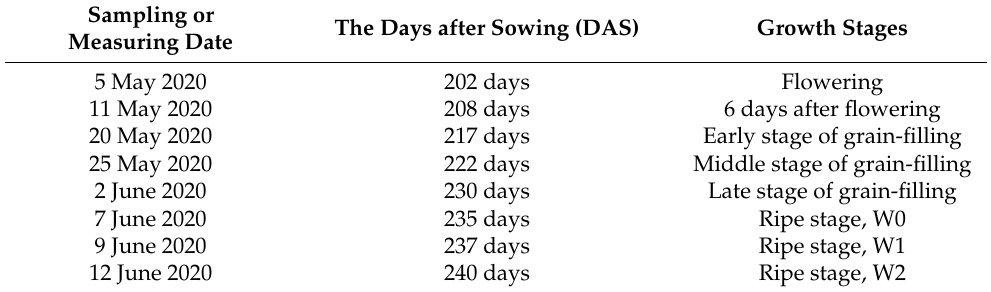
Table 1. The sampling or measuring date corresponds to the days after sowing and the growth stages. Sampling